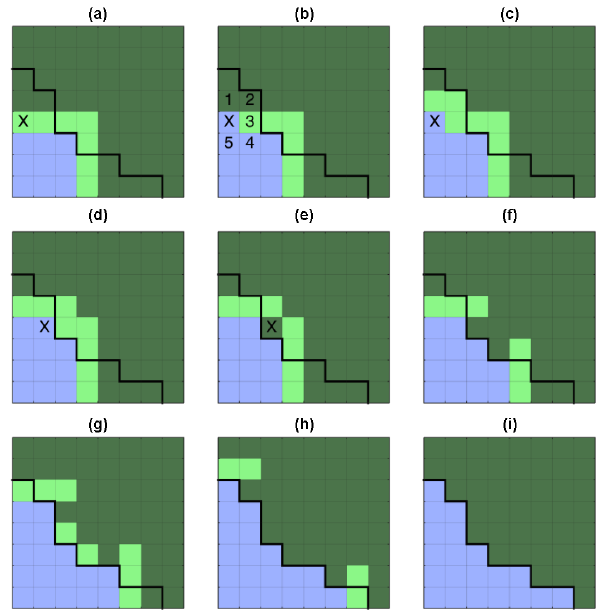
Figure 1. An illustration of the default flood-fill algorithm. Dark green: unfilled; light green: stack; blue: filled. Black line: shoreline. (a) The algorithm starts at the first element in the stack (marked with X). (b) The element is found to meet the fill criterion and is filled. Its immediate neighbours (marked 1–5) are now